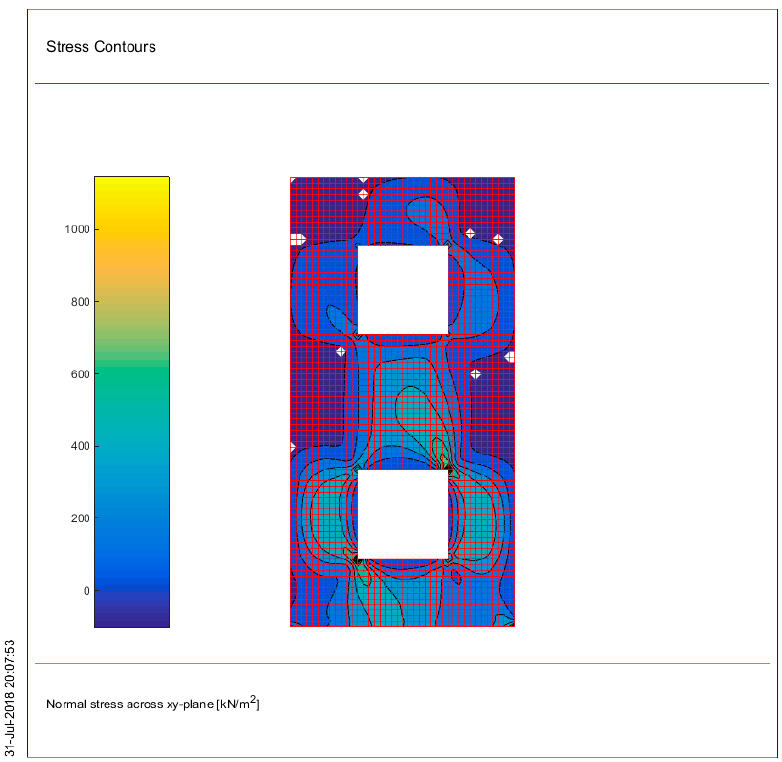
Figure 20. Stress contours of shear stress (PGA = 0.40 g).